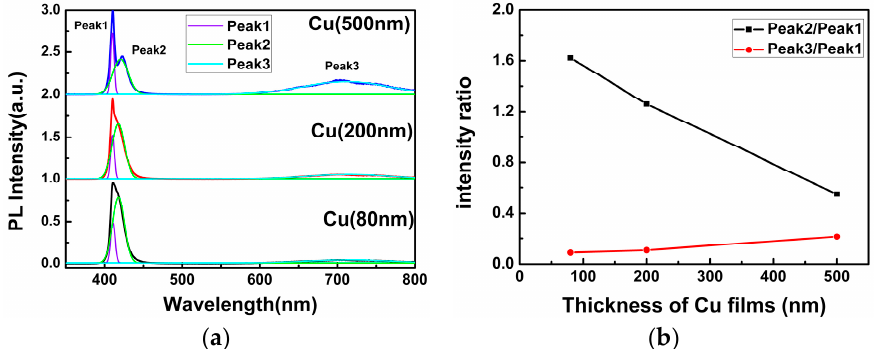
Figure 4. ( a ) Photoluminescence (PL) spectra of the as-grown CuI samples under different thickness of Cu films; ( b ) The intensity ratios of the different PL peaks.